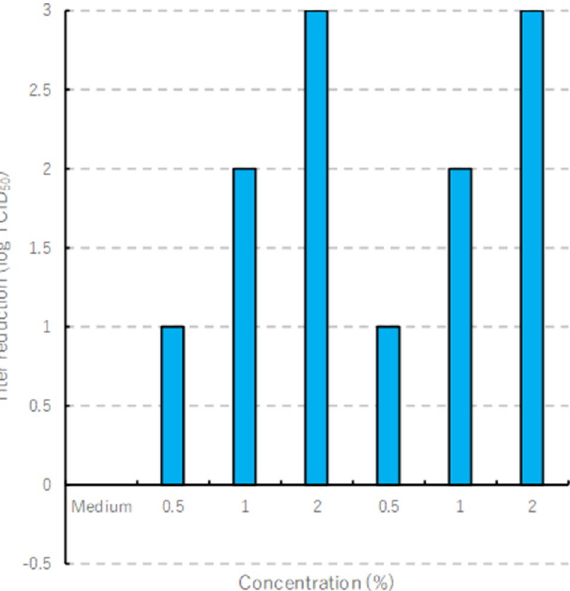
Figure 1. Relationship between the concentration of the heat-denatured lysozyme and inactivation of FMDV